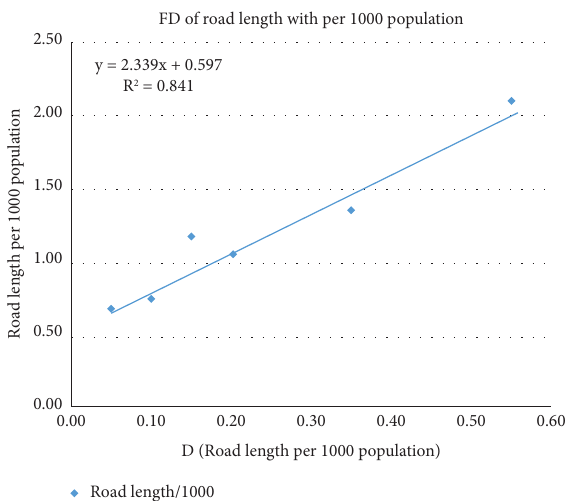
Figure 10: FD of road length with per 1000